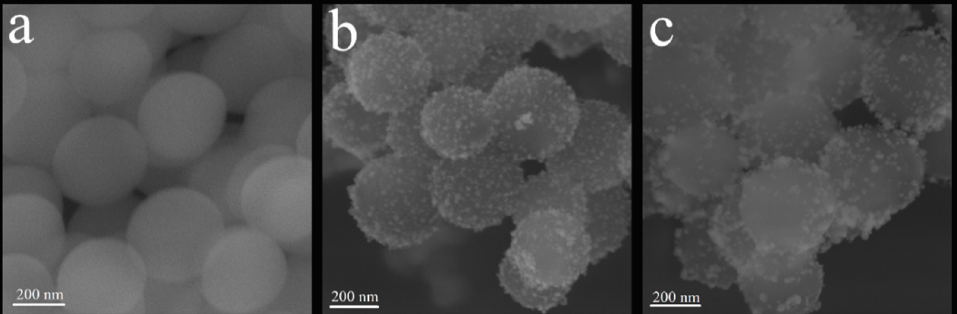
Figure 2. Images obtained by FE-SEM of the samples ( a ) pure SiO 2 , ( b ) non-functionalized SiO 2 -Ag, ( c ) SiO 2 -Ag functionalized by MPS.